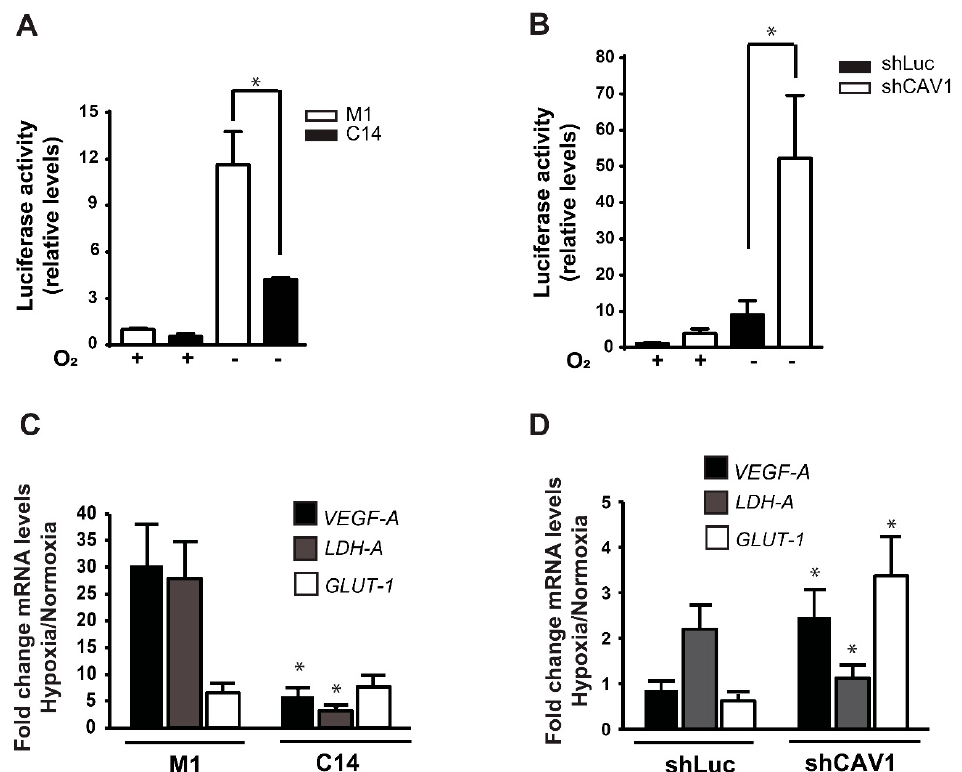
Figure 2. CAV1 reduces HIF-gene reporter activity and target gene expression in tumor cells. Hypoxia-